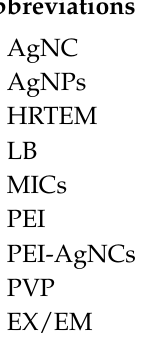
Figure S1: The HRTEM images and the corresponding statistic diameters of PEI-AgNCs with PEI molecular weights from 0.6 kDa–1.8